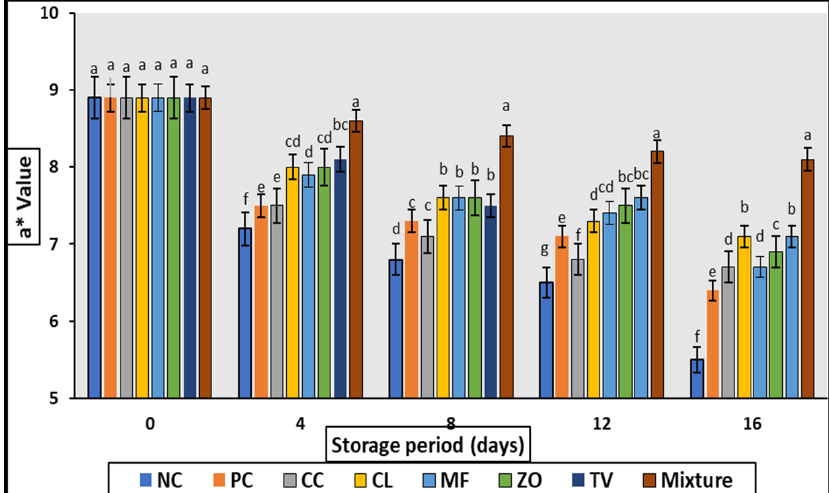
Figure 1. Changes in a* value of cold stored rabbit meat formulated with different aqueous plant extracts. Columns with different letters are significantly different ( p < 0.05).